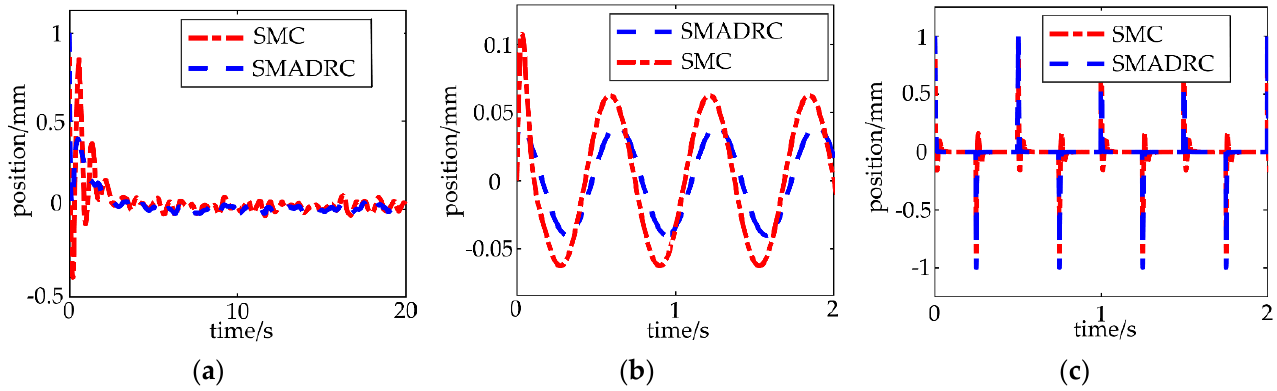
Figure 4. The tracking errors variation under the different controllers, ( a ) Tracking error of step signals, ( b ) Tracking error of sign signals, ( c ) Tracking error of square wave signals.